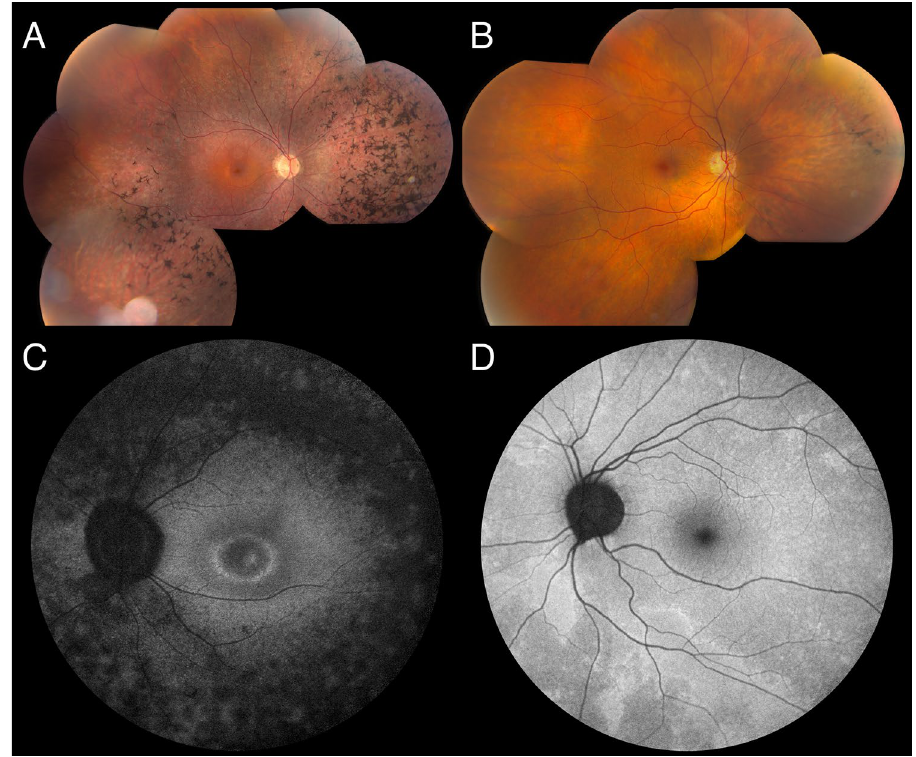
Figure 2. Fundus imaging. ( A ) Fundus pictures of both eyes of individual III.1 (age 28): note RPE alterations in retinal midperiphery and periphery. Spicular intraretinal pigment migrations in the periphery. ( B ) Fundus pictures of both eyes of individual II.1 (age 52): Midperipheral RPE alterations and pigment migrations, more pronounced in, but not exclusive to nasal midperiphery. ( C ) Blue light autofluorescent imaging of both eyes of individual III.1 (age 28): mottled hypo-autofluorescent periphery, with small hyper-autofluorescent ring around the macula, with a second hyperfluorescent ring around temporal vascular arcades. ( D ) Blue